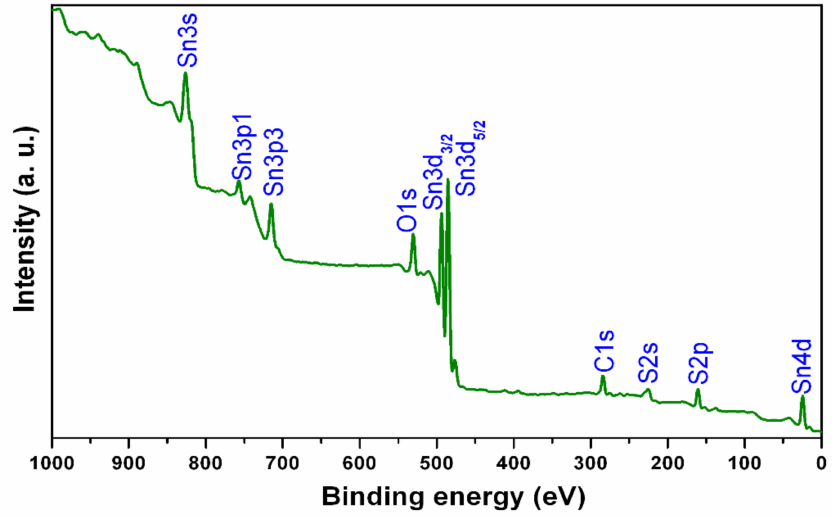
Figure 2. X-ray photoelectron spectroscopy (XPS) wide scan spectrum of film sulfurized at sulfuriza- tion time of 150